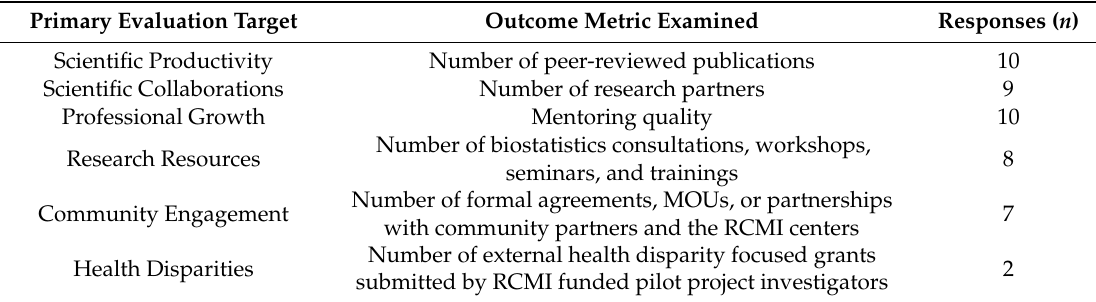
Table 2. Number of Research Centers in Minority Institutions that completed the di ff erent sections of the case study survey ( n =